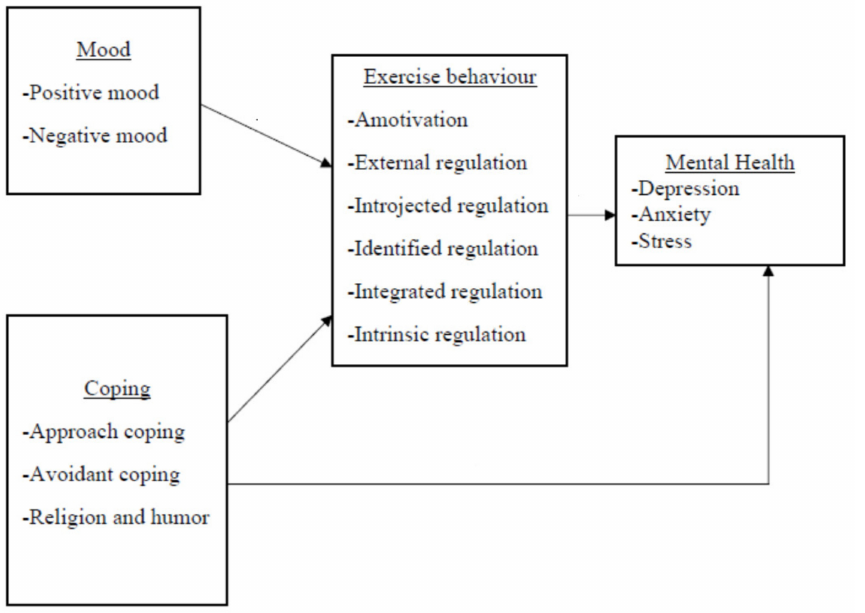
Figure 1. Proposed hypothesized relationships of mood state, coping skills, exercise behavior, and mental